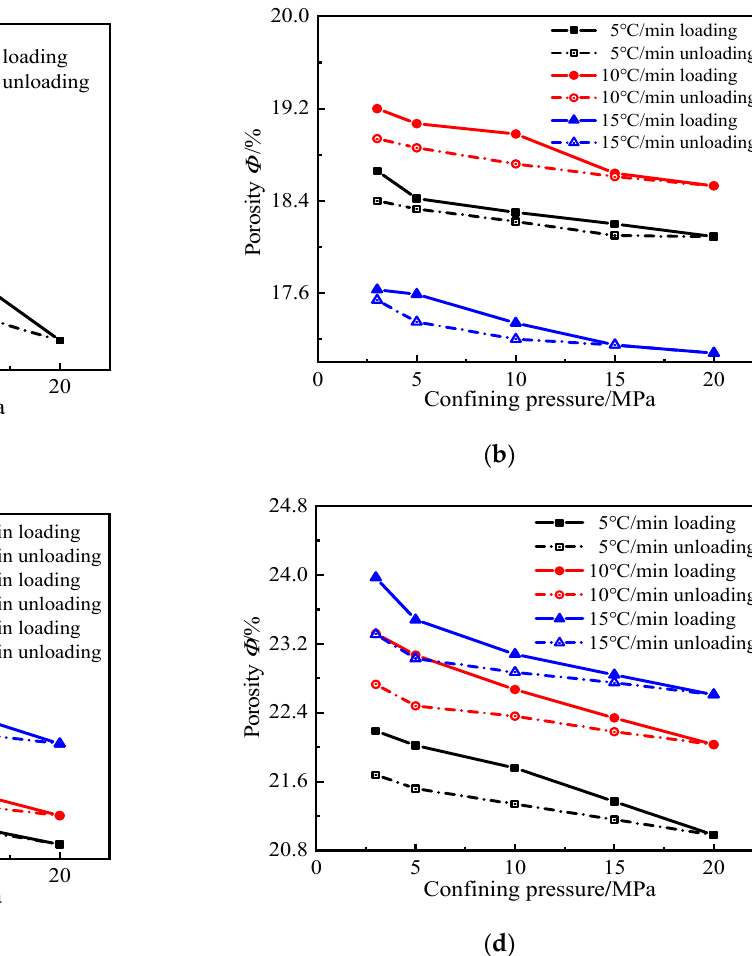
Figure 6. Variation in porosity under confining pressure loading and unloading: ( a ) 60 °C; ( b ) 400 °C; ( c ) 500 °C; ( d ) 600 °C.